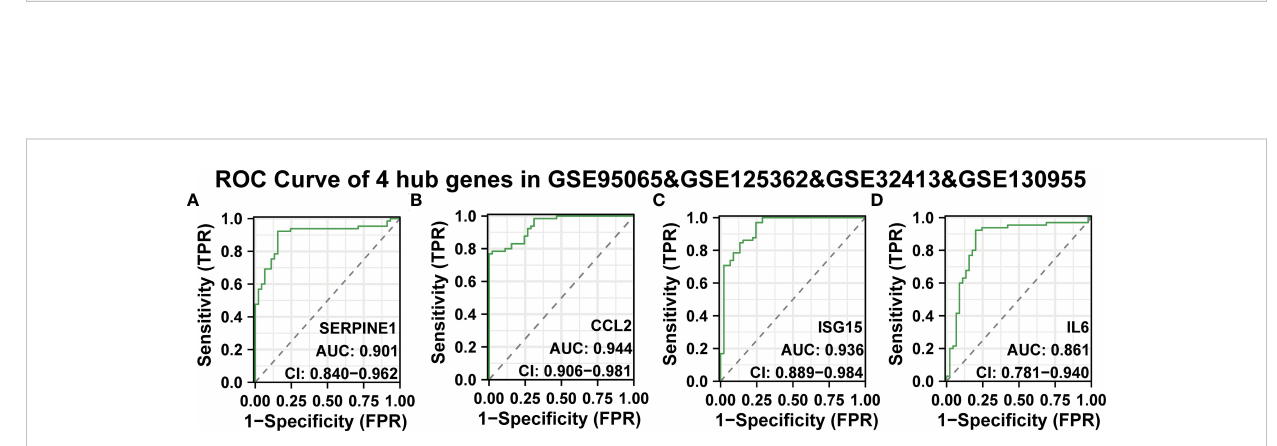
FIGURE 6 ROC curve of the four speci fi cally expressed hub genes. (A-D) The GSE95065, GSE125362, GSE32413, and GSE130955 datasets were used to validate the diagnostic effectiveness of the four speci fi cally expressed hub genes by ROC analysis. AUC is the area under the ROC